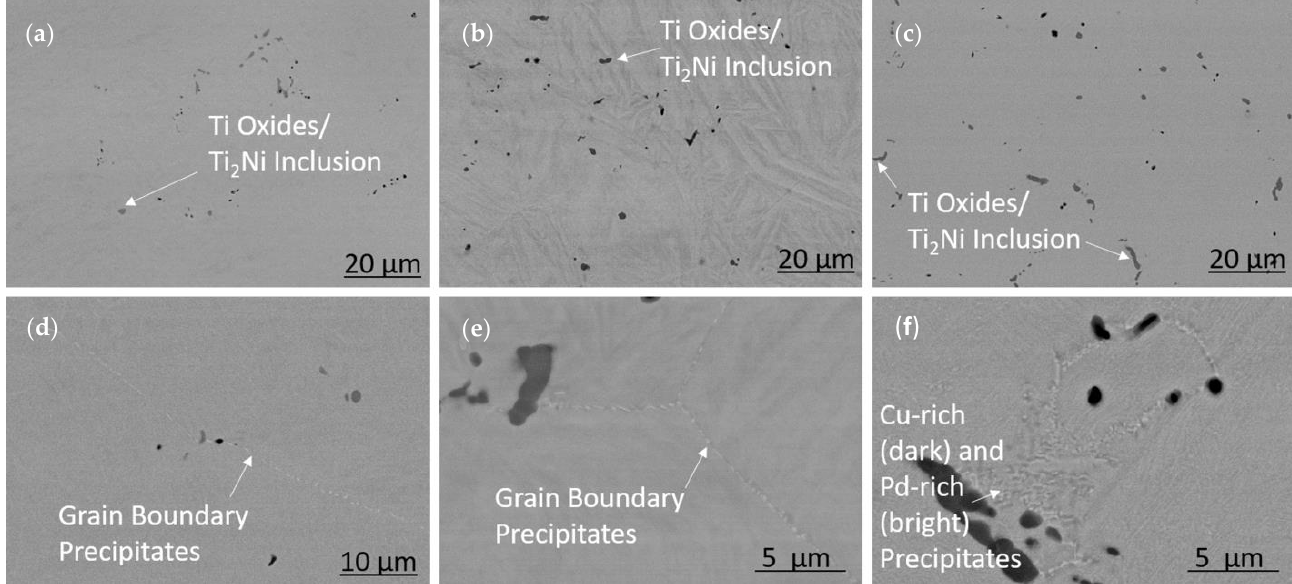
Figure 8. The microstructure of aged (550 °C × 3 h) group B VIM alloys: SEM micrographs of the ( a , d ) 5-Pd; ( b , e ) 15-Pd; and ( c , f ) 20-Pd alloys in two different magnifications.